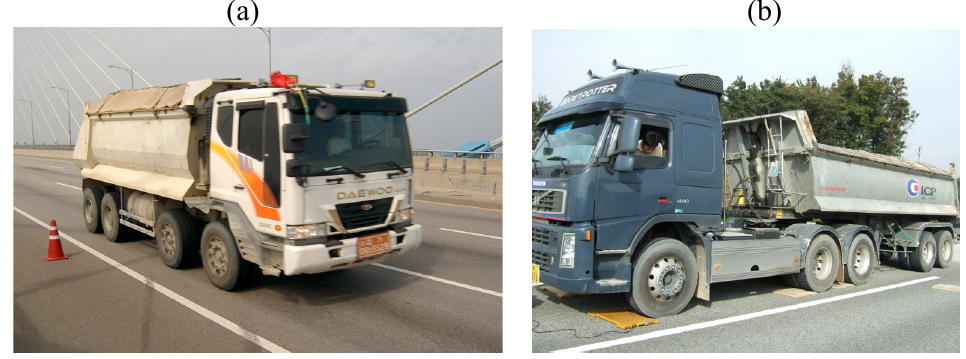
Figure 5. (a) Experimental test on Seohae Bridge. (b) Static weighing of test trucks for Geumdang